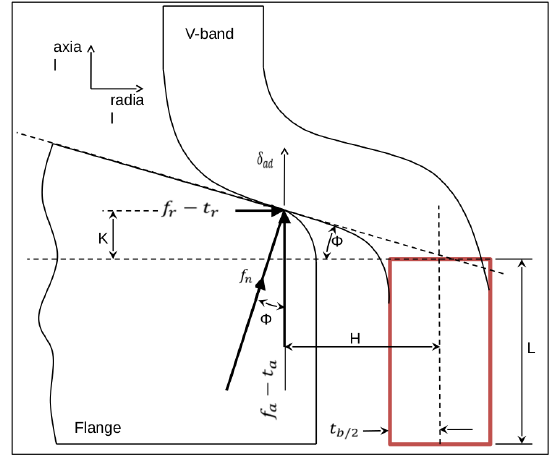
Figure 9: V-band cross section with cantilever (dash line rectangle) assumed in the